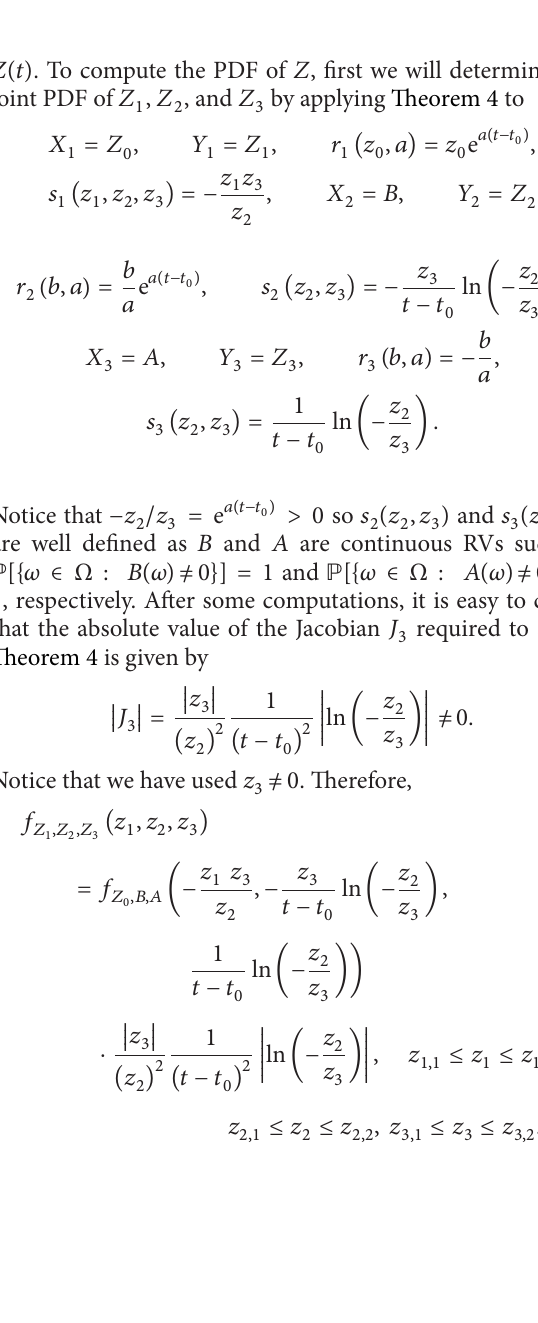
Figure 13: Plot of 𝑓 1 (𝑧,𝑡) given by (152) in Example 23 at different values of 𝑡 = {0.1, 0.2, .. ., 1} (a) and 𝑡 = {1, 1.1, .. ., 2} (b) in the case that = 0 and 𝑡 = 0 and the joint PDF of (𝐵,𝐴) is given by (150). In order to better highlight the shape of 𝑓 𝑧 0 0 into two plots. Notice the different scales in the vertical axes for each